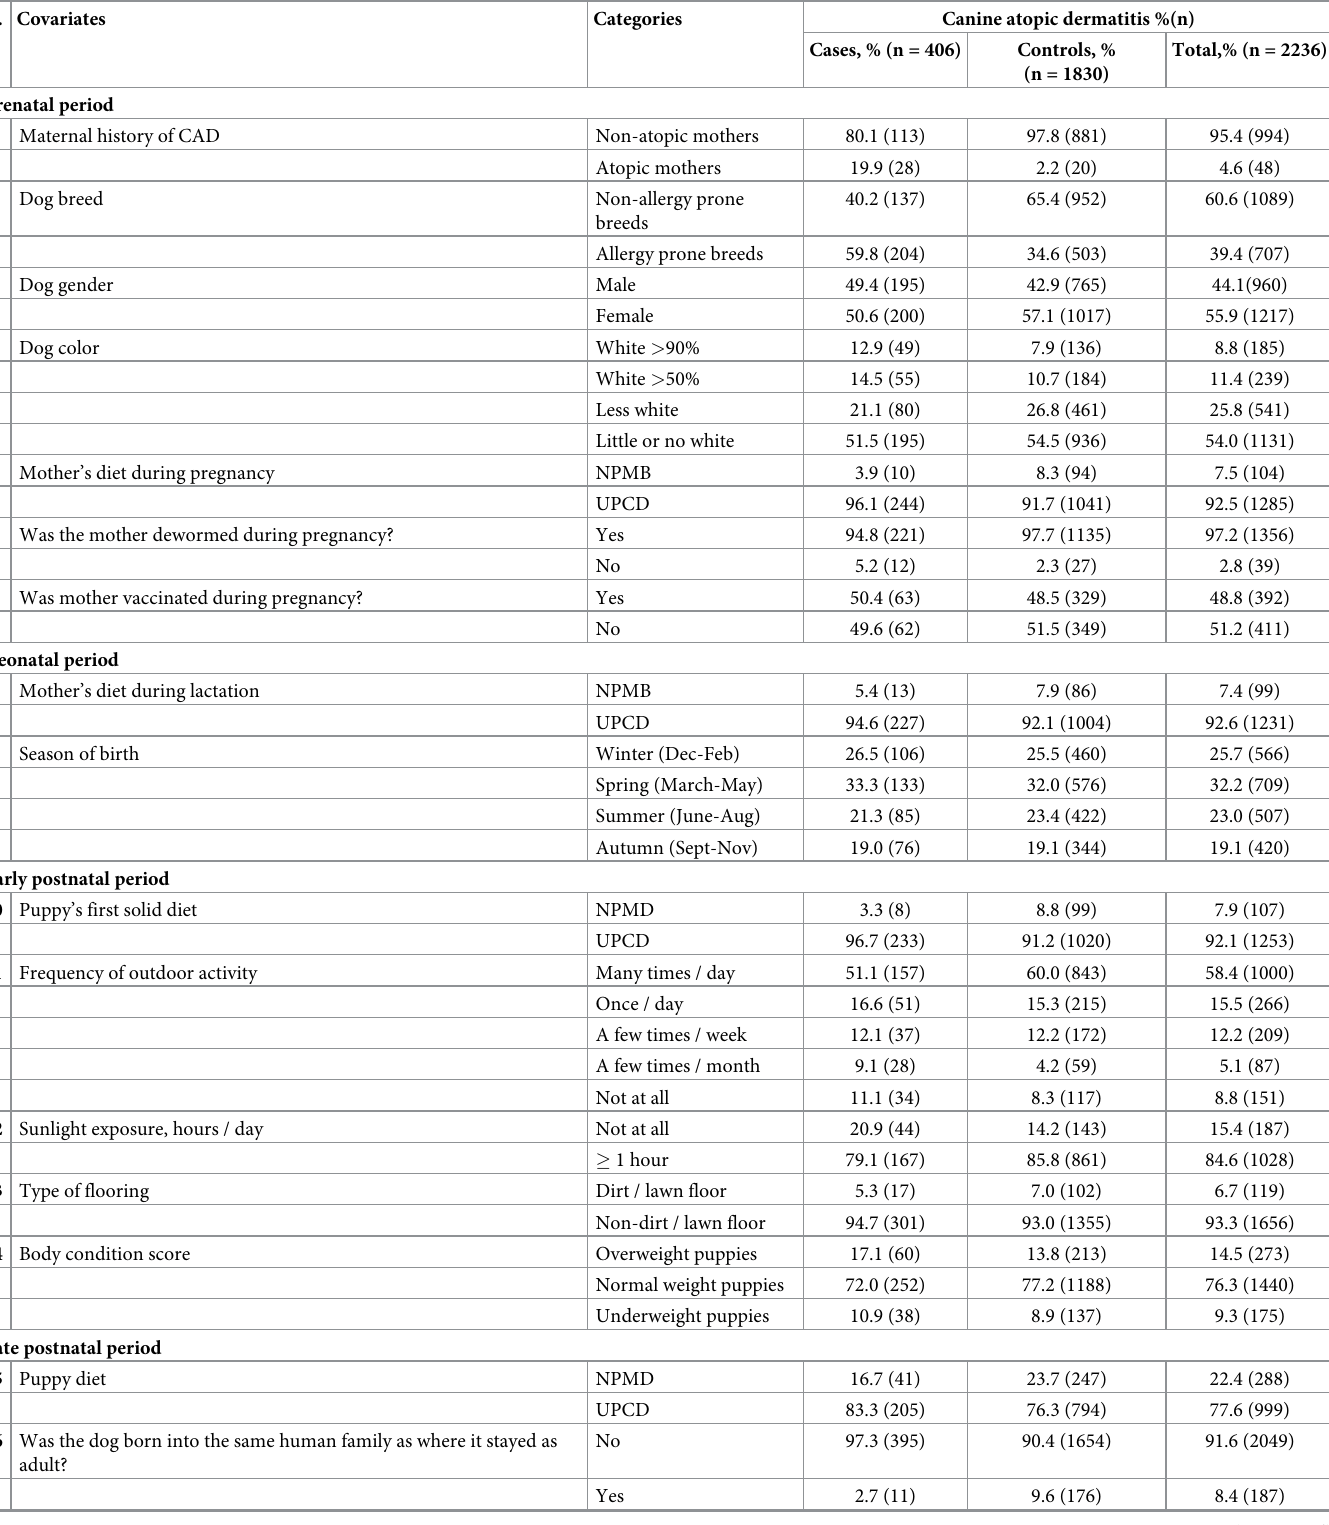
Table 1. Variable characteristics and their distribution within study cases, controls and the total study population. N.